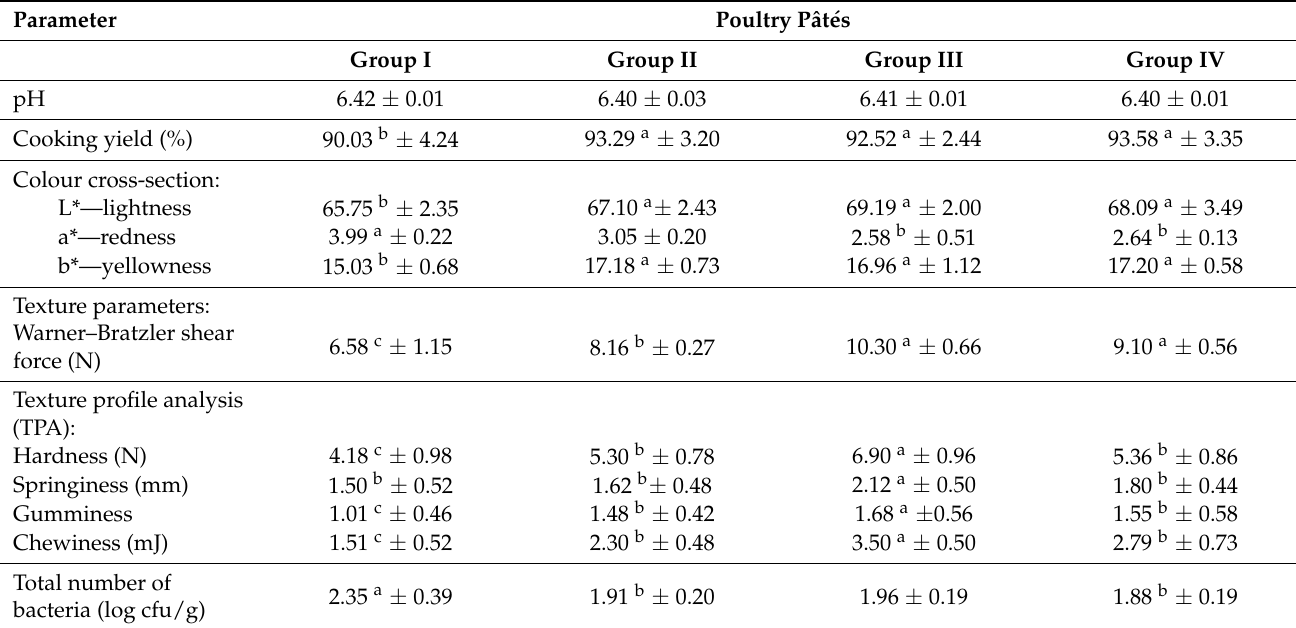
Table 2. Effect of the addition of hemp seeds, amaranth and golden flaxseed on the physical charac- teristics and total number of bacteria of poultry p â t é s (x ±